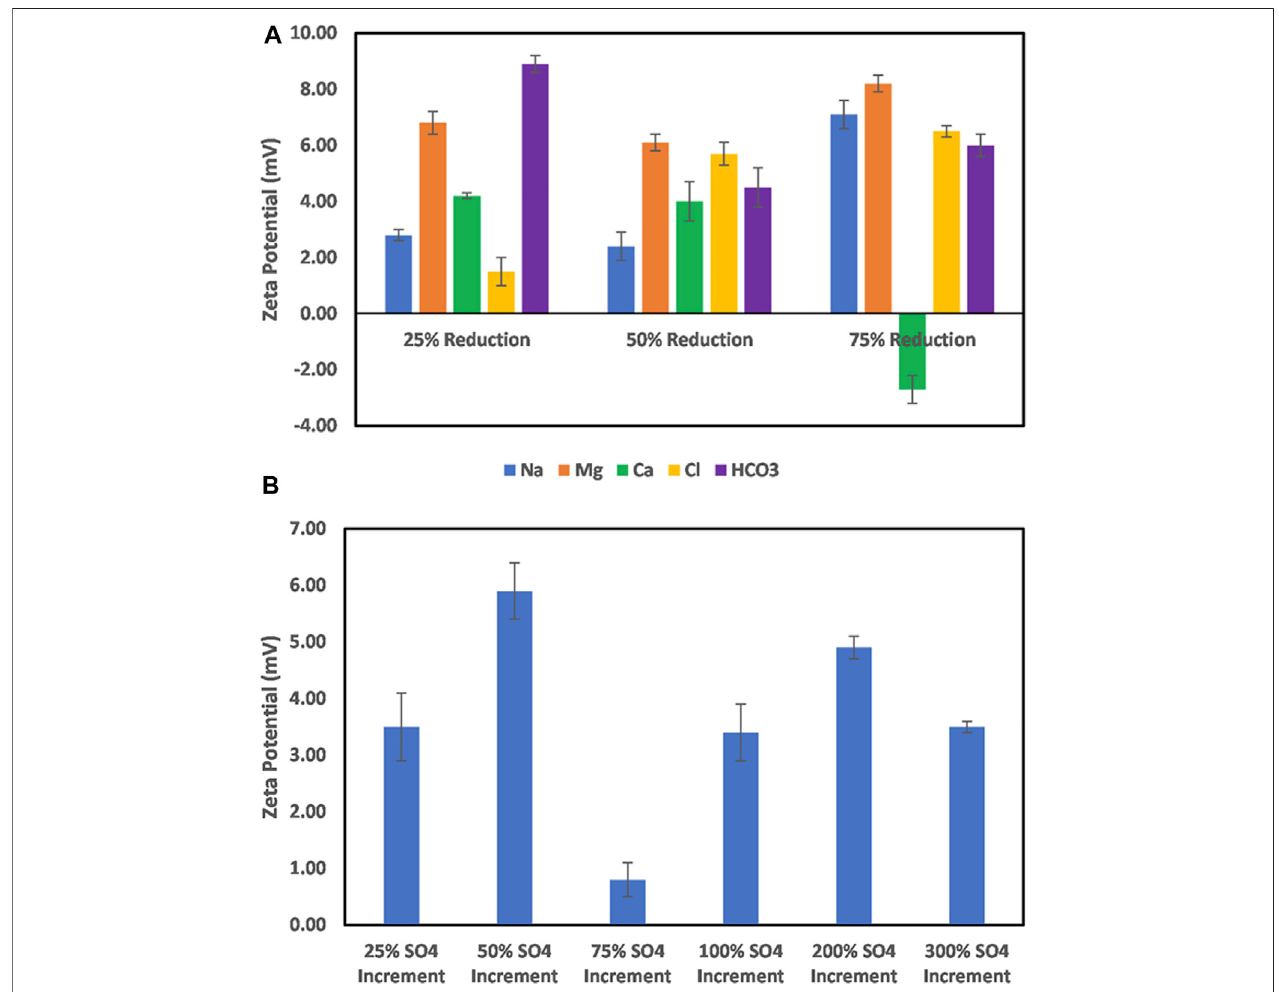
FIGURE 9 | (A) Effect of Na, Mg, and Ca, and HCO 3 ion concentration reduction on dolomite mineral surface charge. (B) Effect of increase in the sulfate ion concentration on dolomite mineral surface charge.